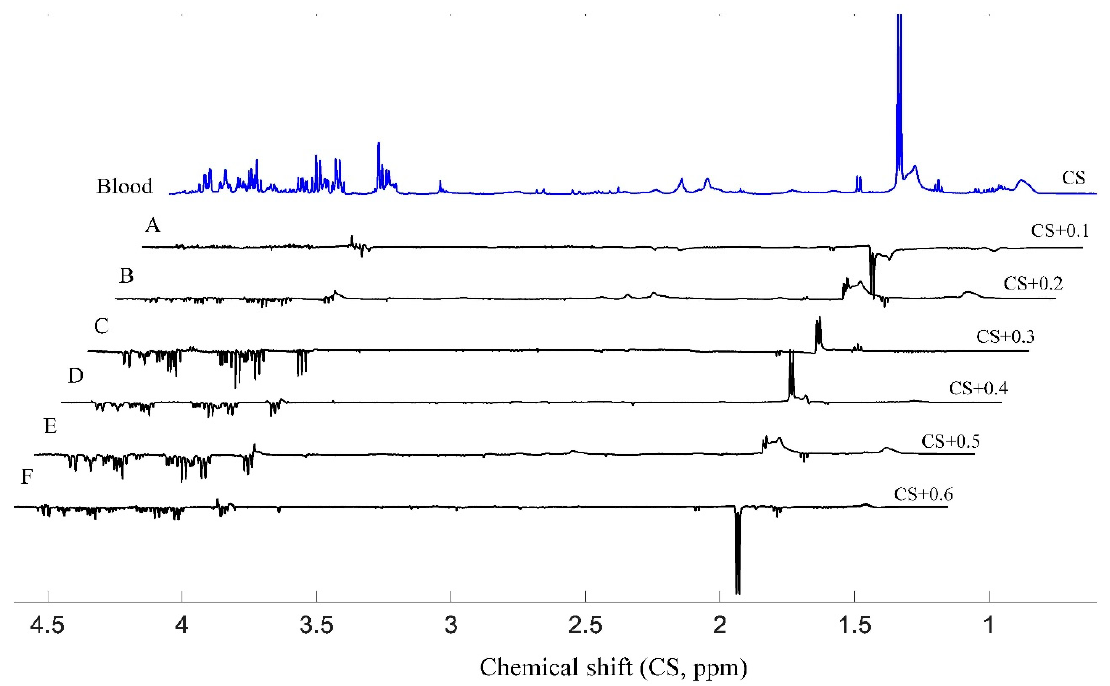
Figure 3. Differences of the average 1 H–NMR spectra of blood samples from different approaches. A) Figure 3. Di ff erences of the average 1 H–NMR spectra of blood samples from di ff erent